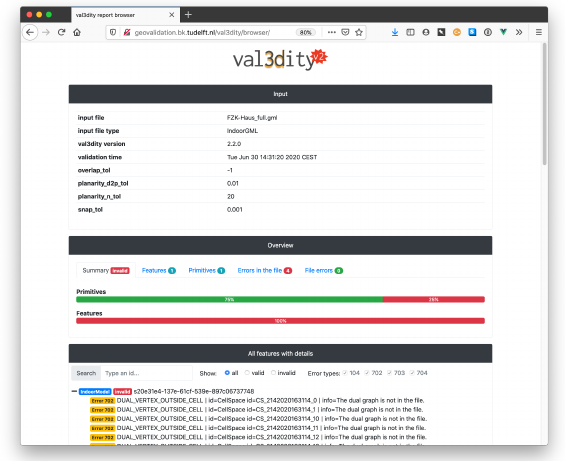
Figure 5. The web-based validation report browser.